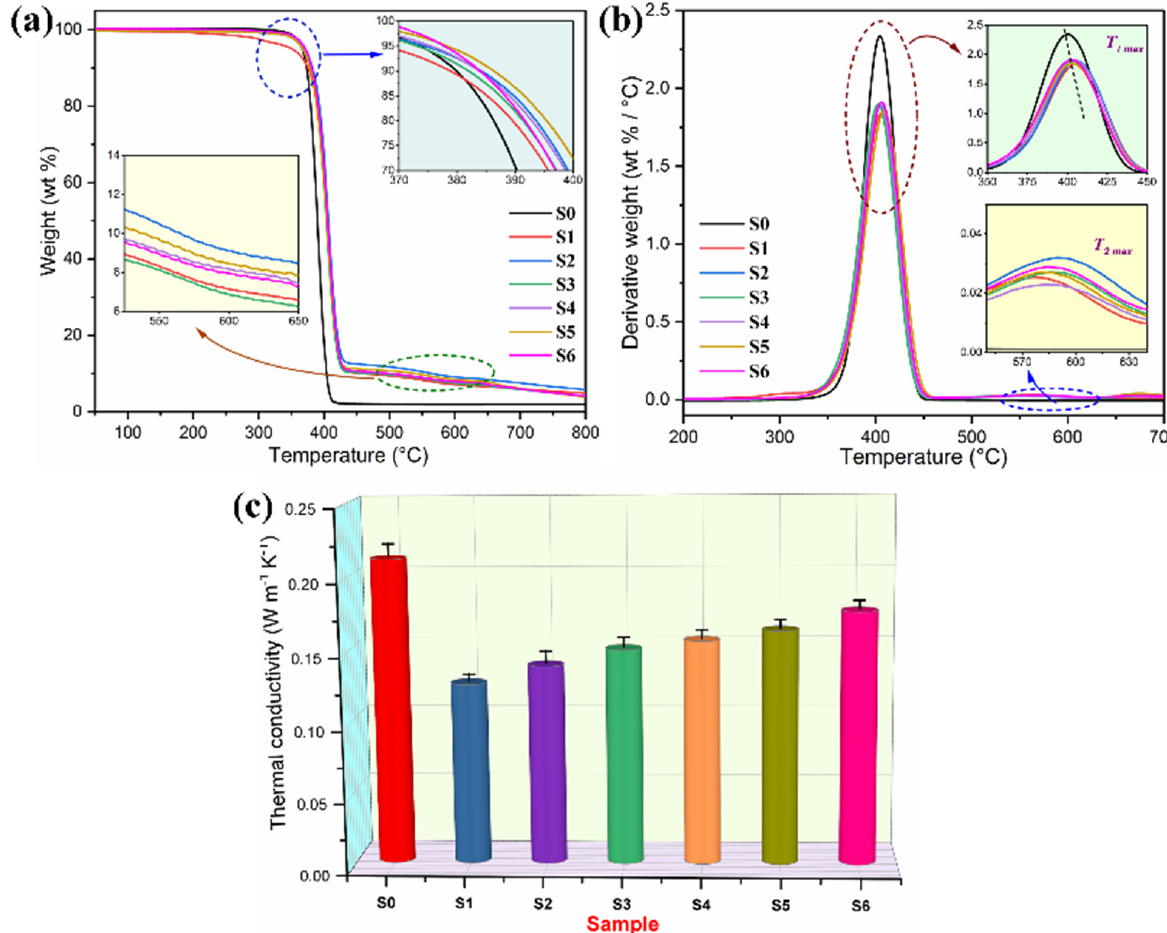
Figure 13. ( a ) TGA thermograms, ( b ) DTG curves, ( c ) Thermal conductivities of (S0) pure PEG, (S1) PI aerogel/PEG composite film, and PI/graphene/Fe 3 O 4 aerogel/PEG composite films containing 5 wt% graphene nanosheets and (S2) 0, (S3) 2, (S4) 4, (S5) 6 and (S6) 8 wt% Fe 3 O 4 nanosheets.